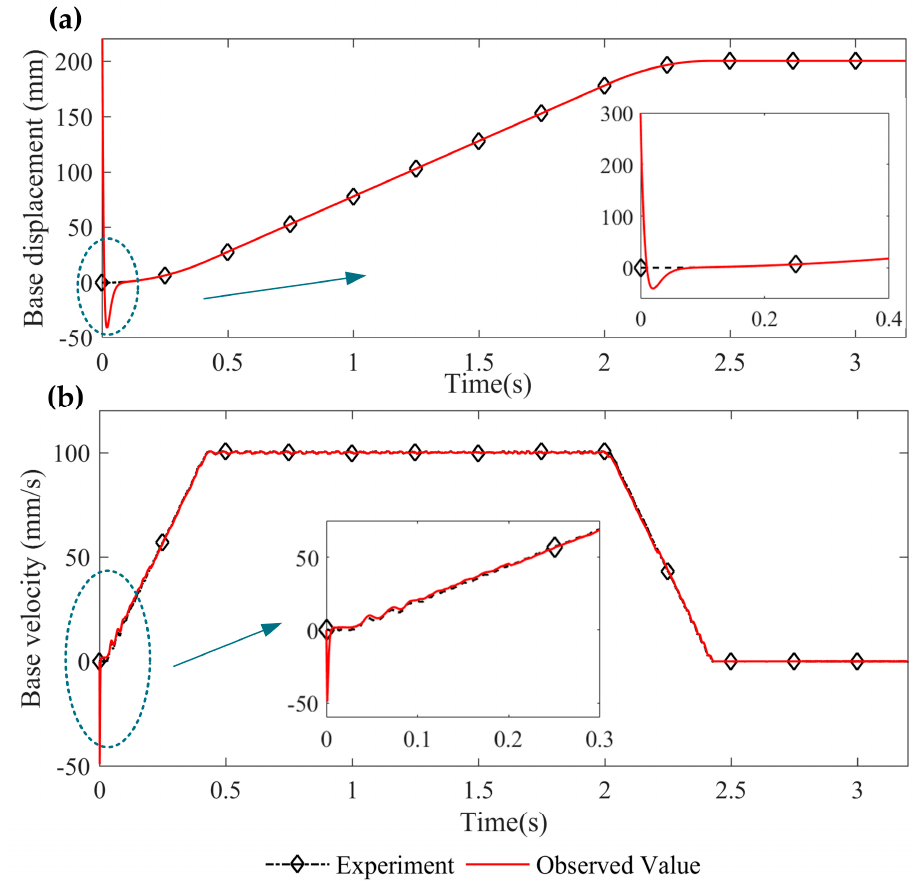
Figure 8. Base displacement and velocity observation: ( a ) base displacement tracking and ( b ) base velocity tracking.